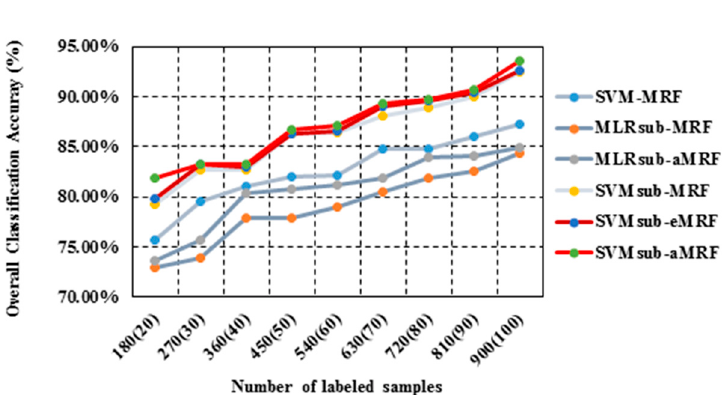
Figure 9. Overall accuracy results as a function of the number of labeled samples per class for the University of Pavia data set.